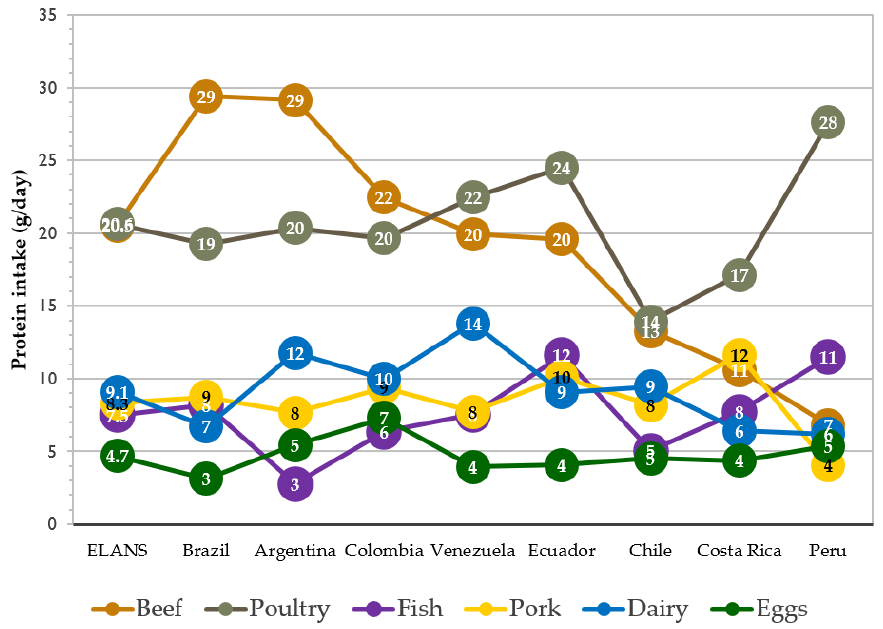
Figure 5. Mean daily animal protein intake (g/day) by food group and ELANS countries.